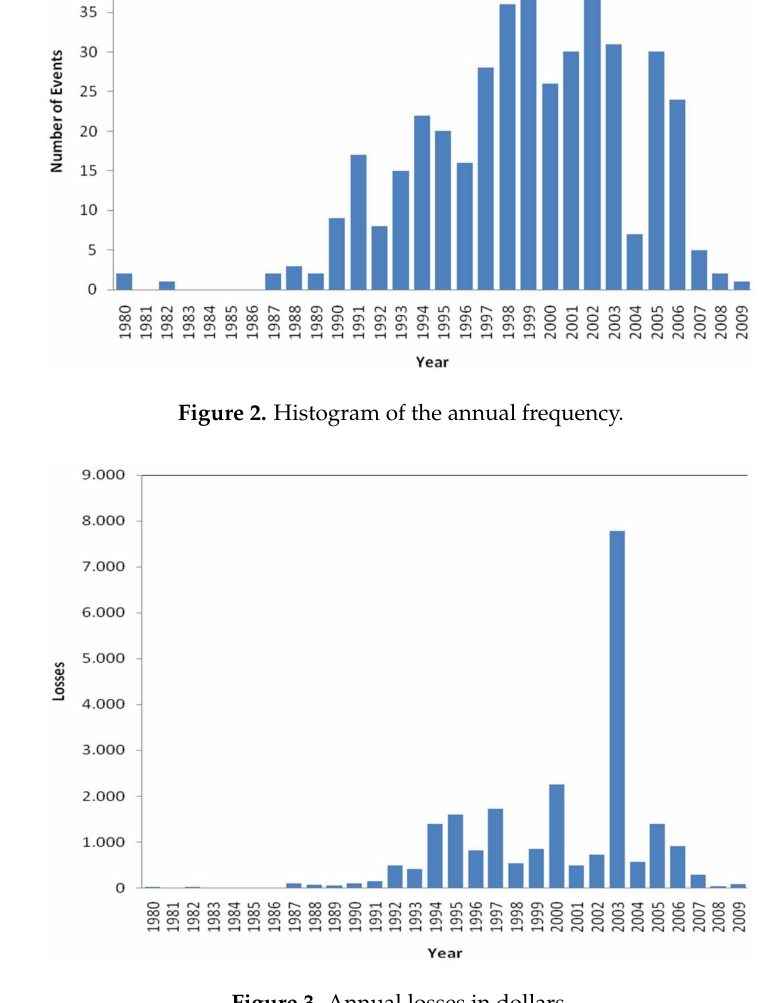
Figure 3. Annual losses in